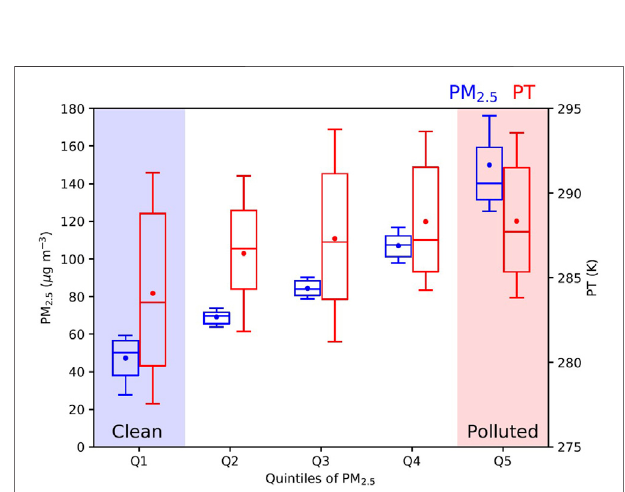
FIGURE 2 | Boxplot showing the changes of daily PM 2.5 concentration (blue) and 850-hPa PT (red) in Wuhan during winter on the days of different quintiles of PM 2.5 concentration (Q1 to Q5). The PTs shown were derived from the radiosonde measurements at 08:00 LT, and the measurements of rainy days (24-h accumulated precipitation greater than 0.5 mm) were excluded. The central box represents the values from the lower to upper quartile (25th to 75th percentile). The vertical line extends from the 0th percentile to the 90th percentile value. The middle solid line represents the median, and the dot represents the mean